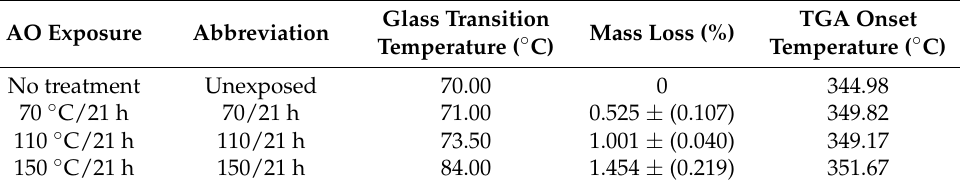
Figure 3. Effects of atomic oxygen (AO) exposure on CF-SMPCs: ( a ) mass loss, ( b ) thermomechanical behavior (straight line—storage modulus, dashed line—tangent delta), ( c ) Fourier transform infrared (FT-IR) spectra and ( d ) thermogravimetric analysis/differential thermal analysis (TGA/DTA) data. Table 2. Thermal properties and mass loss of AO-exposed carbon fiber-reinforced shape memory polymer composites (CF-SMPCs).